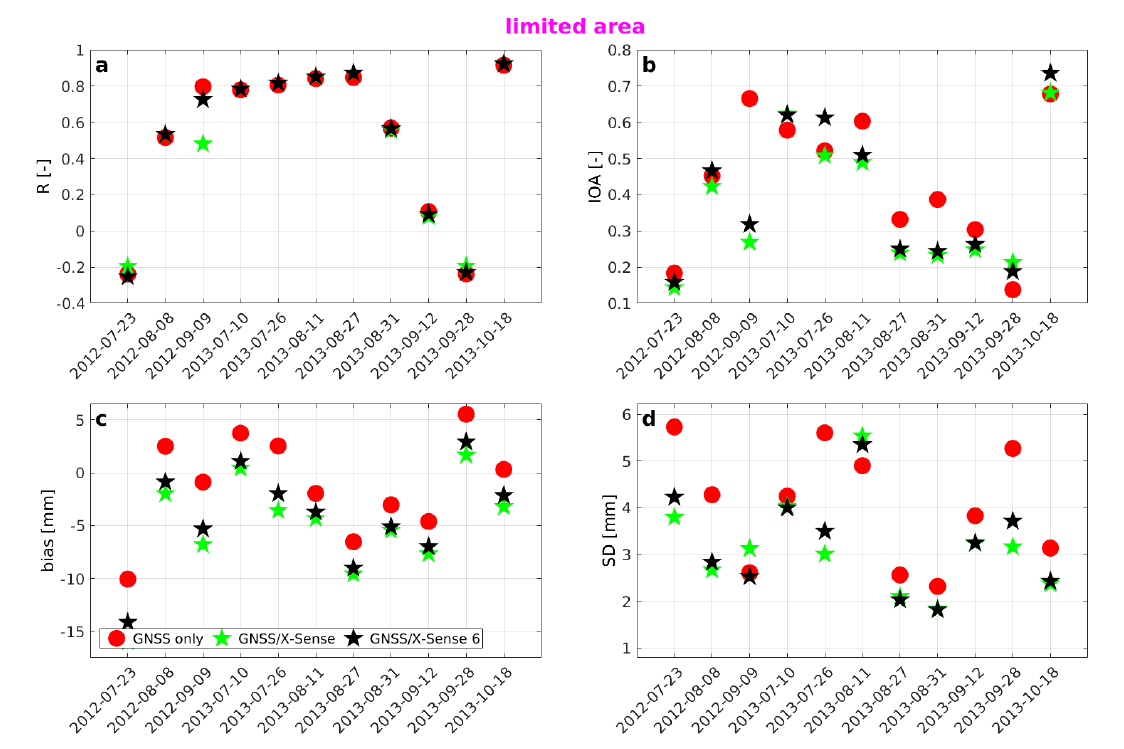
Figure 13. ( a ) correlation coefficients ( b ) IOA ( c ) bias and ( d ) SDs of the differences between InSAR and three data sets: ‘GNSS only’ (red dots), ‘GNSS/X-Sense’ (green stars), ‘GNSS/X-Sense 6’ (black stars) averaged over the limited 7 km × 7 km area for 11 acquisitions that corresponds to the availability of the X-Sense